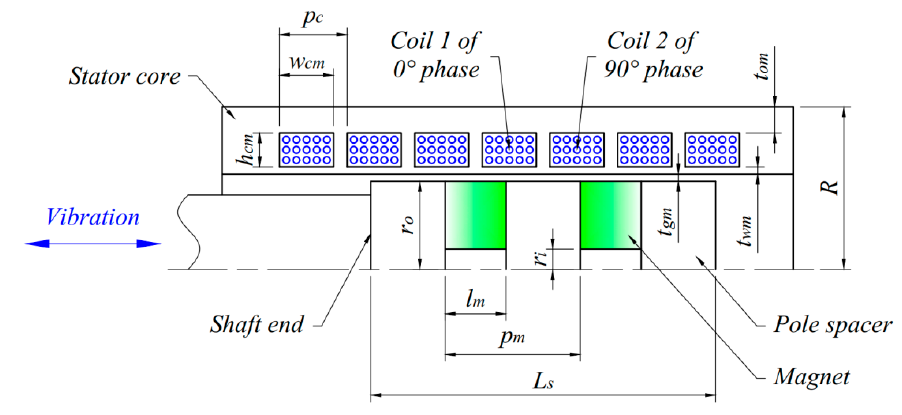
Figure 3. Schematic of the energy-harvesting part.